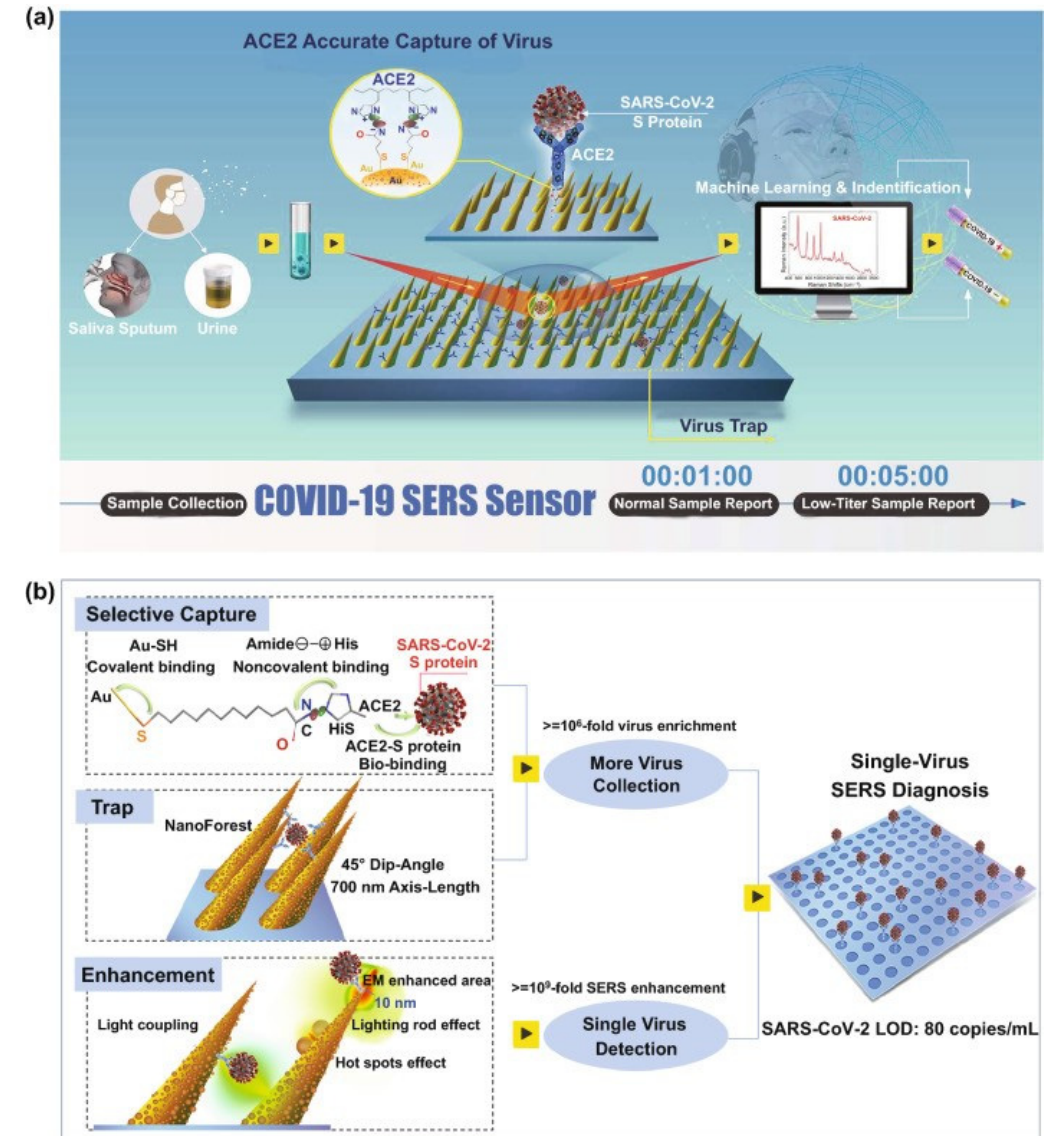
Figure 14. Schematic diagram of COVID-19 SERS sensor design and single-virus detection mecha- nism. ( a ) Schematic diagram of COVID-19 SERS sensor design and operation procedure. SARS-CoV-2 can be localized by a ‘virus-traps’ nanoforest composed of oblique gold-nanoneedles array (GNAs), and be captured by ACE2 anchored on amide-modified GNAs from virus-containing urine, even with complex multi-protein circumstances. Through machine learning and identification techniques, the identification standards of virus signals are established, and utilized for virus diagnoses. ( b ) Schematic diagrams of single-virus detection by selectively capturing and trapping virus, and the multi-SERS enhancement mechanism. Reproduced with permission from [100]. Copyright 2021 Yang et